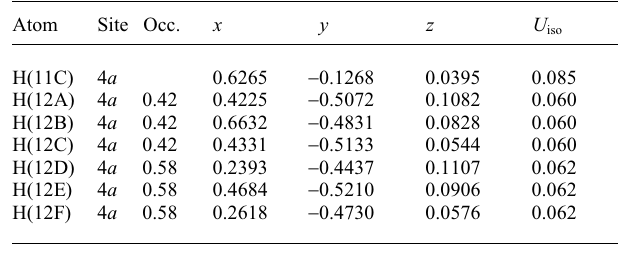
Table 3. Atomic coordinates and displacement parameters (in Å 2 )